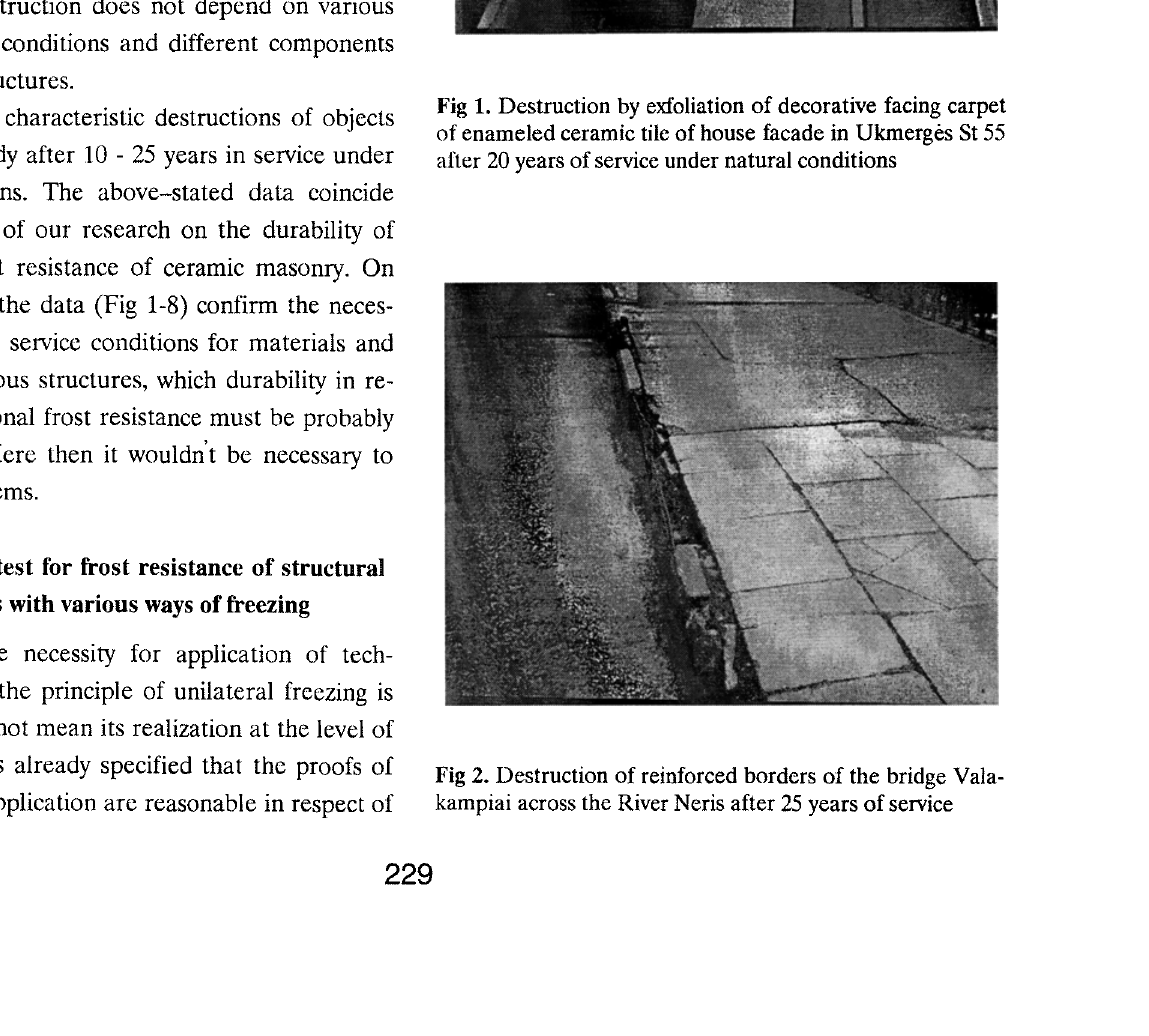
Fig 2. Destruction of reinforced borders of the bridge Vala kampiai across the River Neris after 25 years of